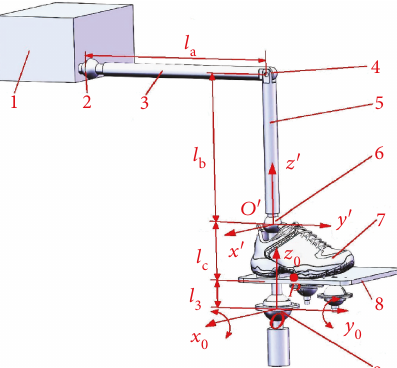
Figure 6: Limit posture of the ankle joint for the dorsi fl exion motion ( α max = 30 ° ).